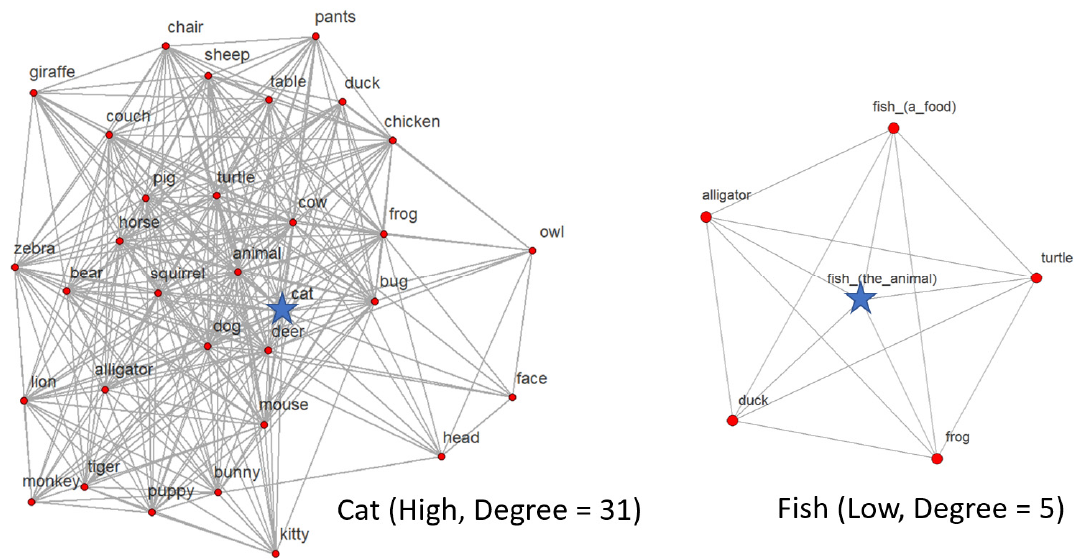
Figure 1. The neighborhoods for “cat” and “fish” (marked by blue stars), extracted from a normative 26-month-old’s (visual–motion and visual–form and surface) perceptual network.